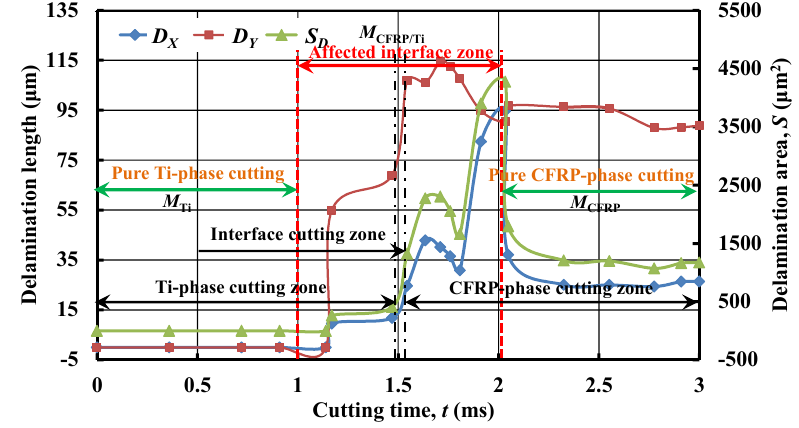
Figure 13. Evolution of delamination damage ( D X , D Y and S D ) as function of cutting time ( t ).